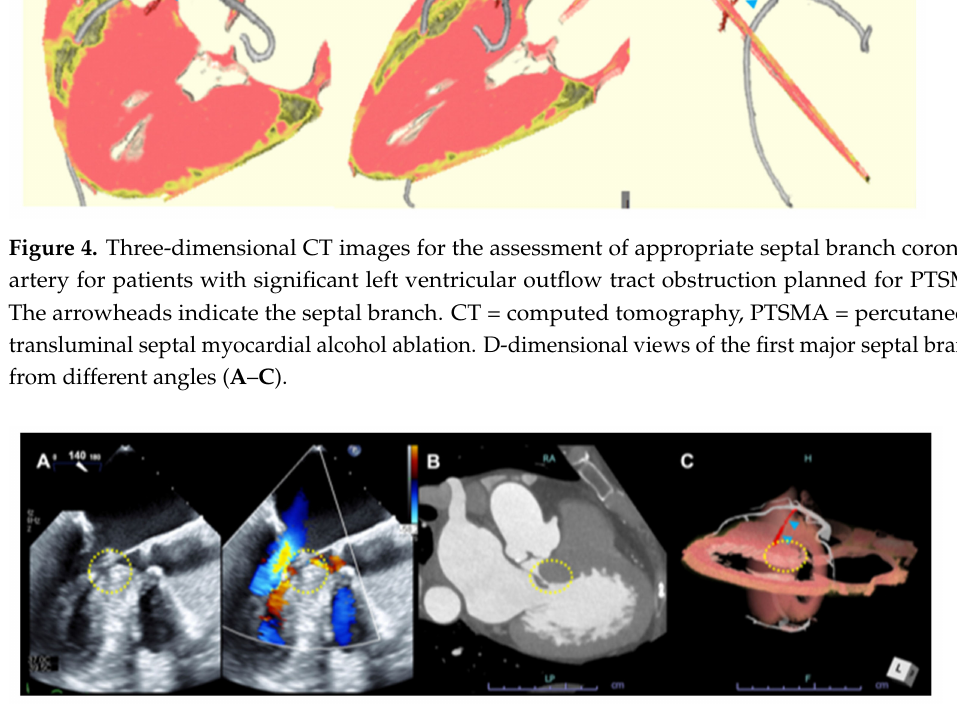
Figure 5. A representative case of LVOT obstruction. Transesophageal echocardiography ( A ), CT images for LVOT obstruction ( B ), and a target septal branch for PTSMA ( C